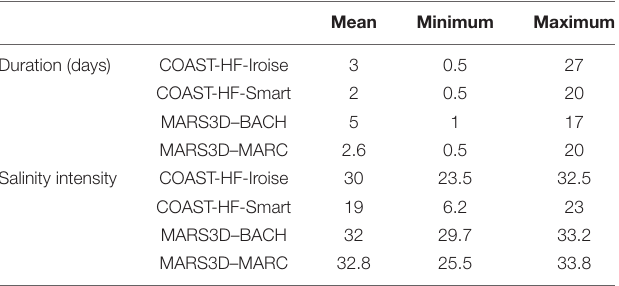
TABLE 3 | Key characteristics of the observed and simulated events.